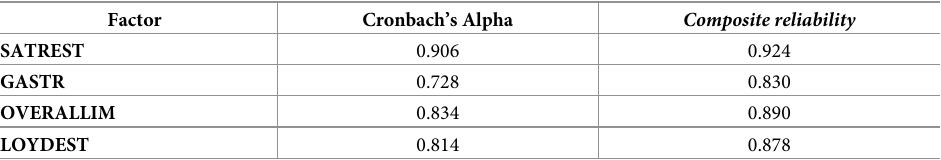
Table 3. Composite reliability.